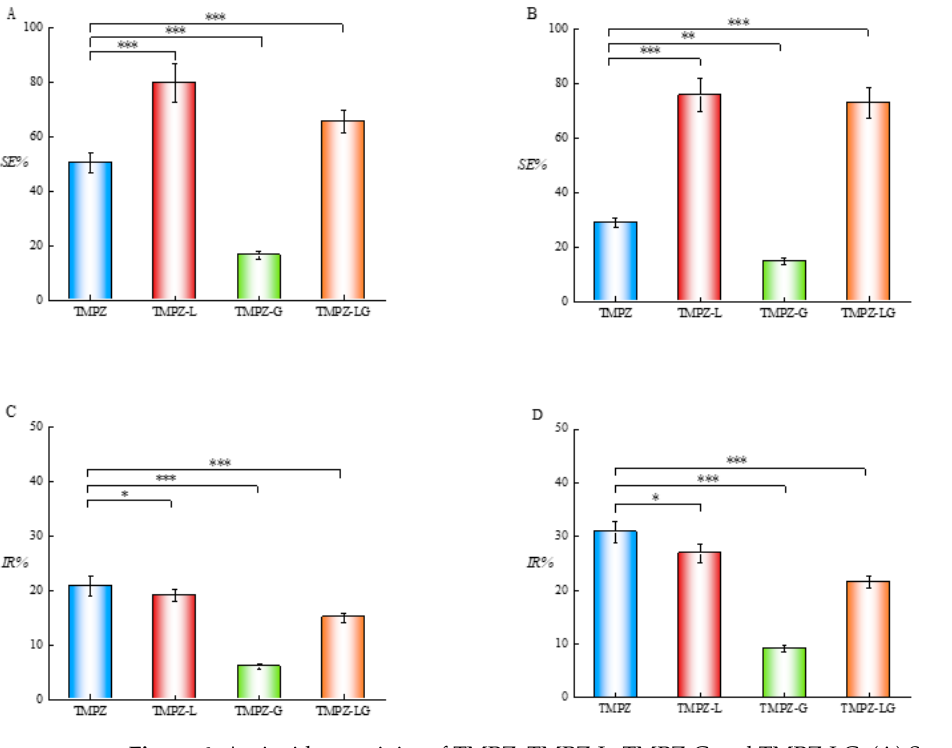
Figure 6. Antioxidant activity of TMPZ, TMPZ-L, TMPZ-G and TMPZ-LG. ( A ) Scavenging effect on DPPH ∙ . ( B ) Scavenging effect on H 2 O 2 . ( C ) Inhibiting rate on MDA production in liver homogenate. ( D ) Inhibiting rate on MDA production in low density lipoprotein. *** p < 0.001; ** p < 0.01; * p < 0.05.